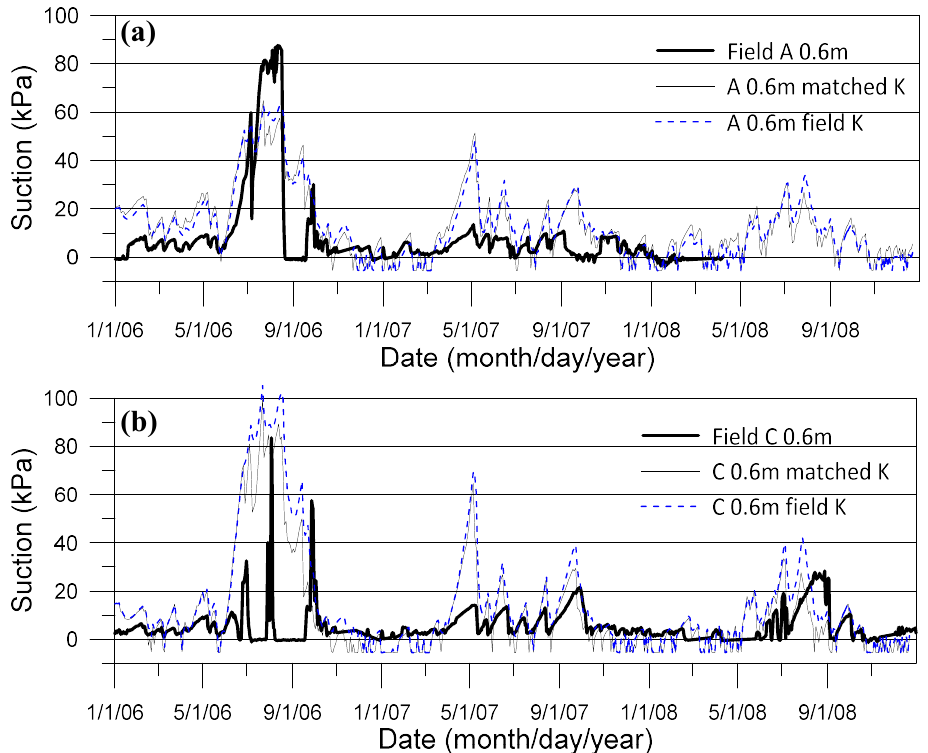
Figure 12. Measured and calculated soil suction at 0.3 m depth ( a ) at section A and ( b ) at section C.